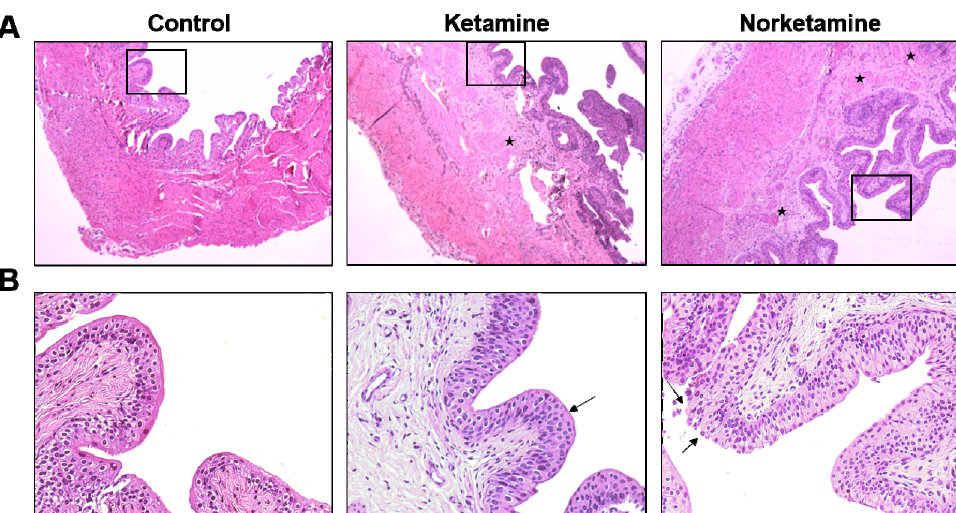
Figure 3. Haematoxylin and eosin staining of the bladder from each group. The images of the upper row ( A ) were taken at 40× magnification and images of the lower row ( B ) were taken at 200× magnification. The star marks indicate the edema sites in the lamina propria, and the damaged glycosaminoglycan (GAG) layer shows in the edge of the epithelial layer (arrows).